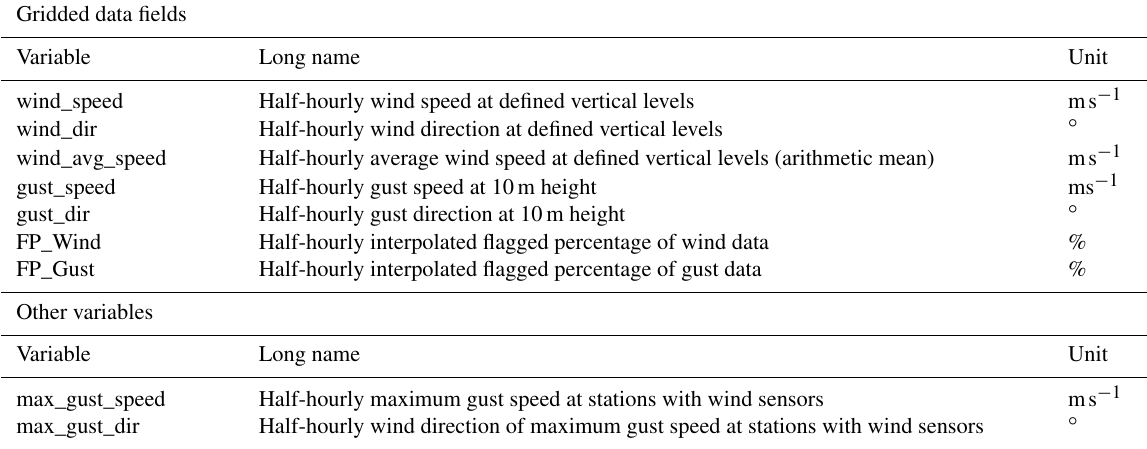
Table A4. List of variables of WegenerNet wind field NetCDF data. Gridded data